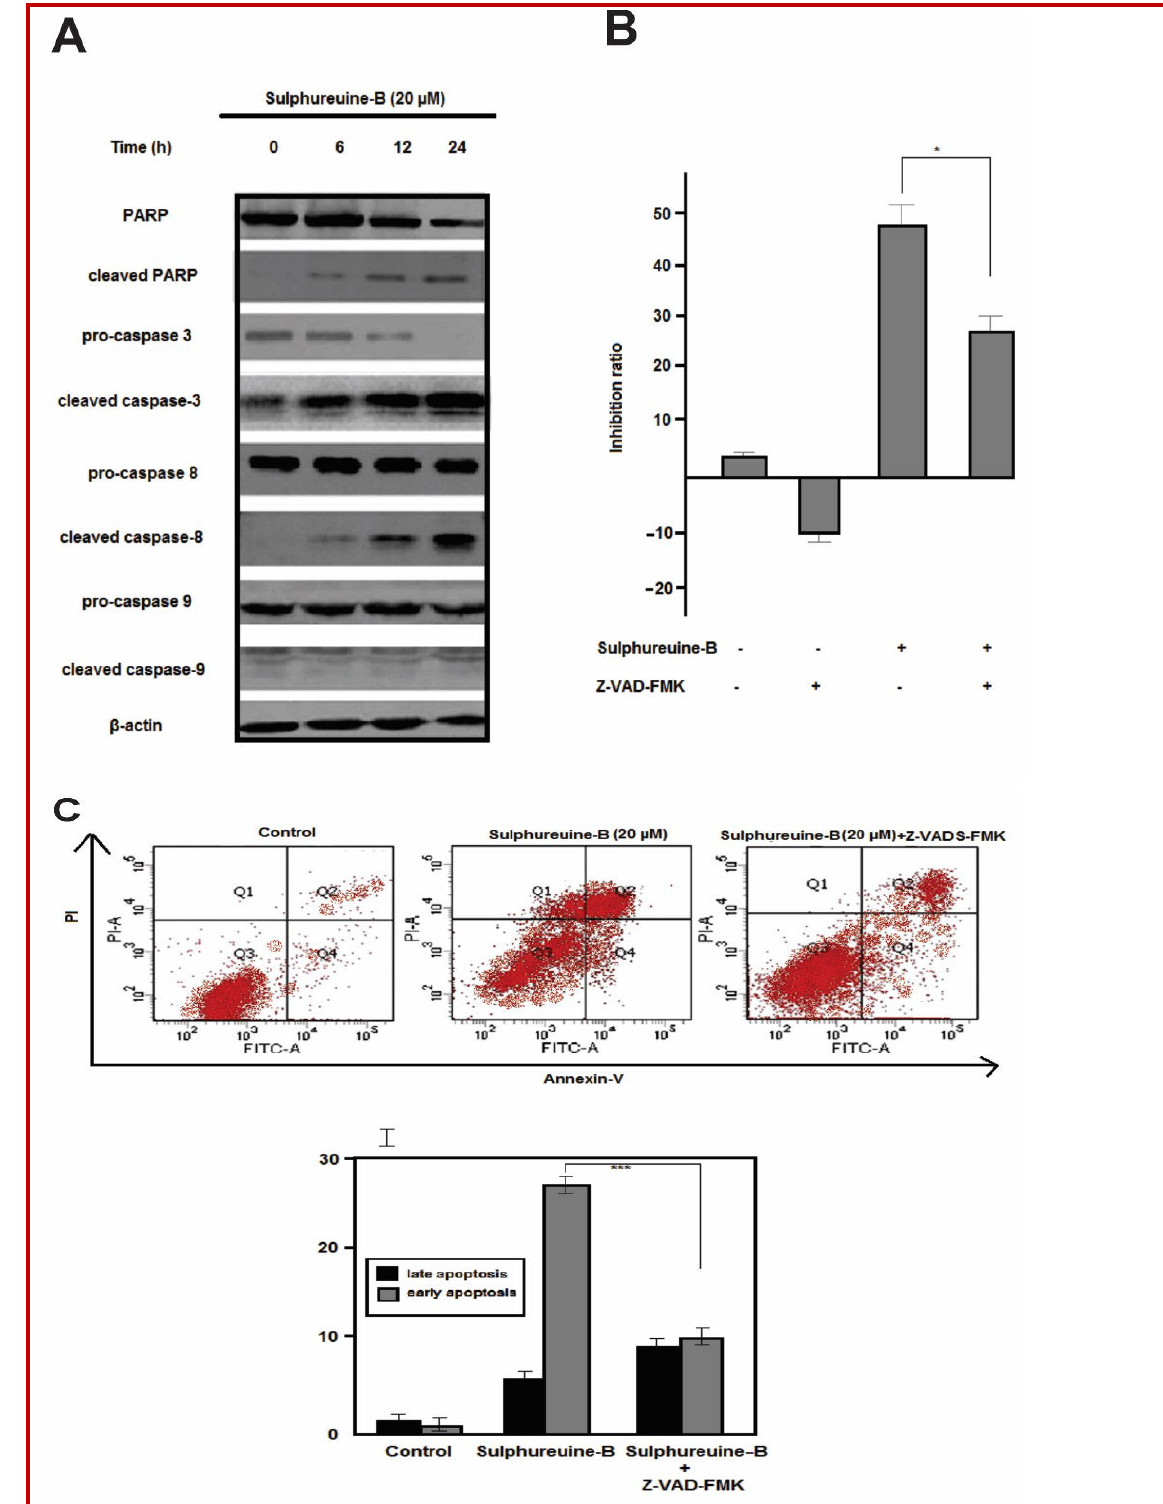
Figure 4: A) Western blot analysis observed upon treating U-87MG cells with 20 µM sulphureuine B for 0, 6, 12 and 24 hours using β - actin as control; B) MTT results upon treatment of U-87MG cells with 20 µM sulphureuine B with or without Z-VAD- FMK (5 µM) and compared with control of sulphureuine B alone; C) Flow cytometry results upon treatment of U-87MG cells with 20 µM sulphureuine B with or without Z-VAD-FMK (5 µM) and compared with control of sulphureuine B